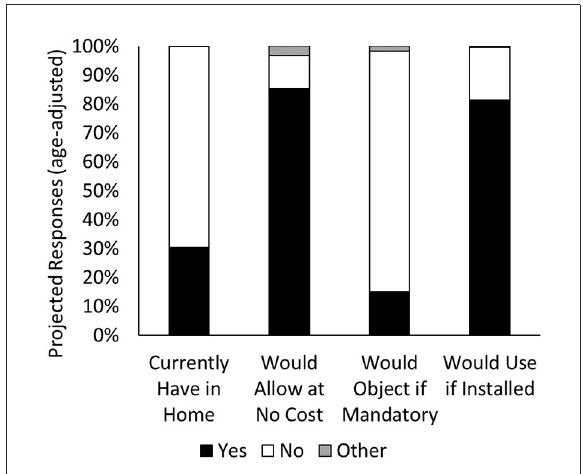
FIGURE1 Overall responses to questions GB1-4, age-adjusted. While most respondents did not have a grab bar in their home bathroom, most responded that they would allow a grab bar to be installed in their home, would not object to mandatory grab bar installation, and would use a grab bar if it were installed in their